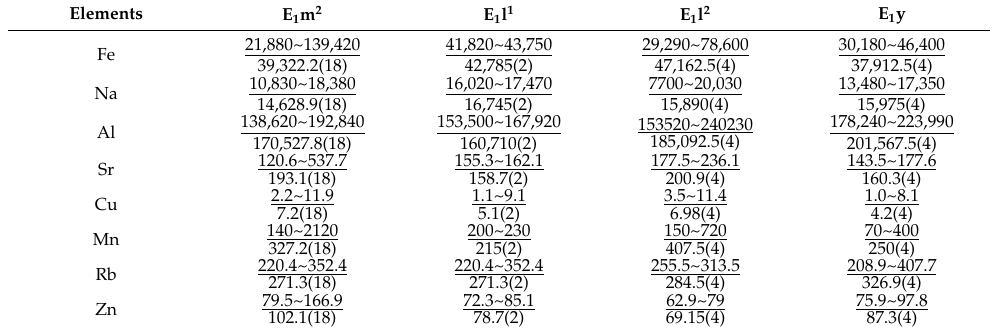
Table 2. The distribution of the major and trace elements of the Paleocene in the West Lishui Sag. Elements